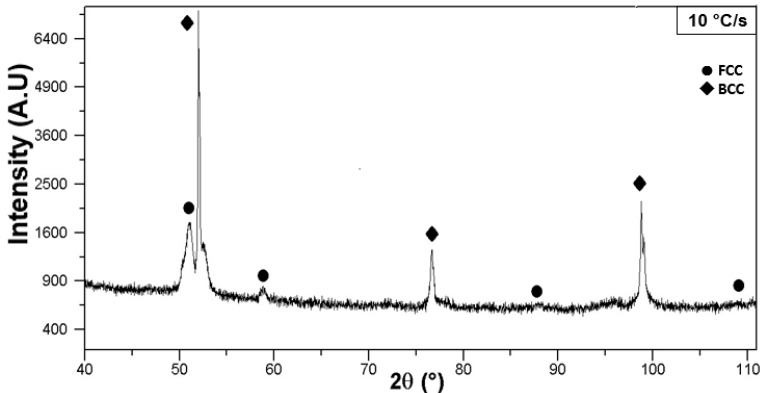
Figure 5. Diffractogram obtained from the dilatometry sample tested at a 10 °C/s cooling rate (radiation: Co k α ).